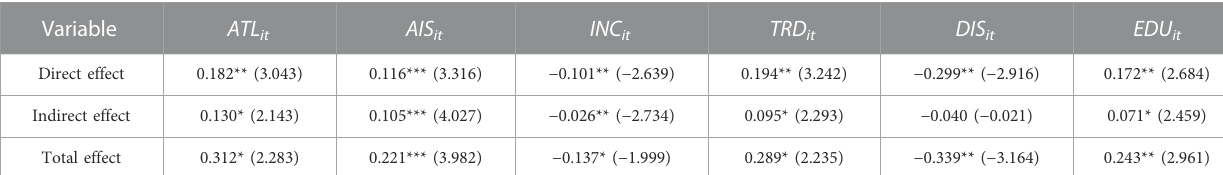
TABLE 9 Decomposition results of spatial effects.